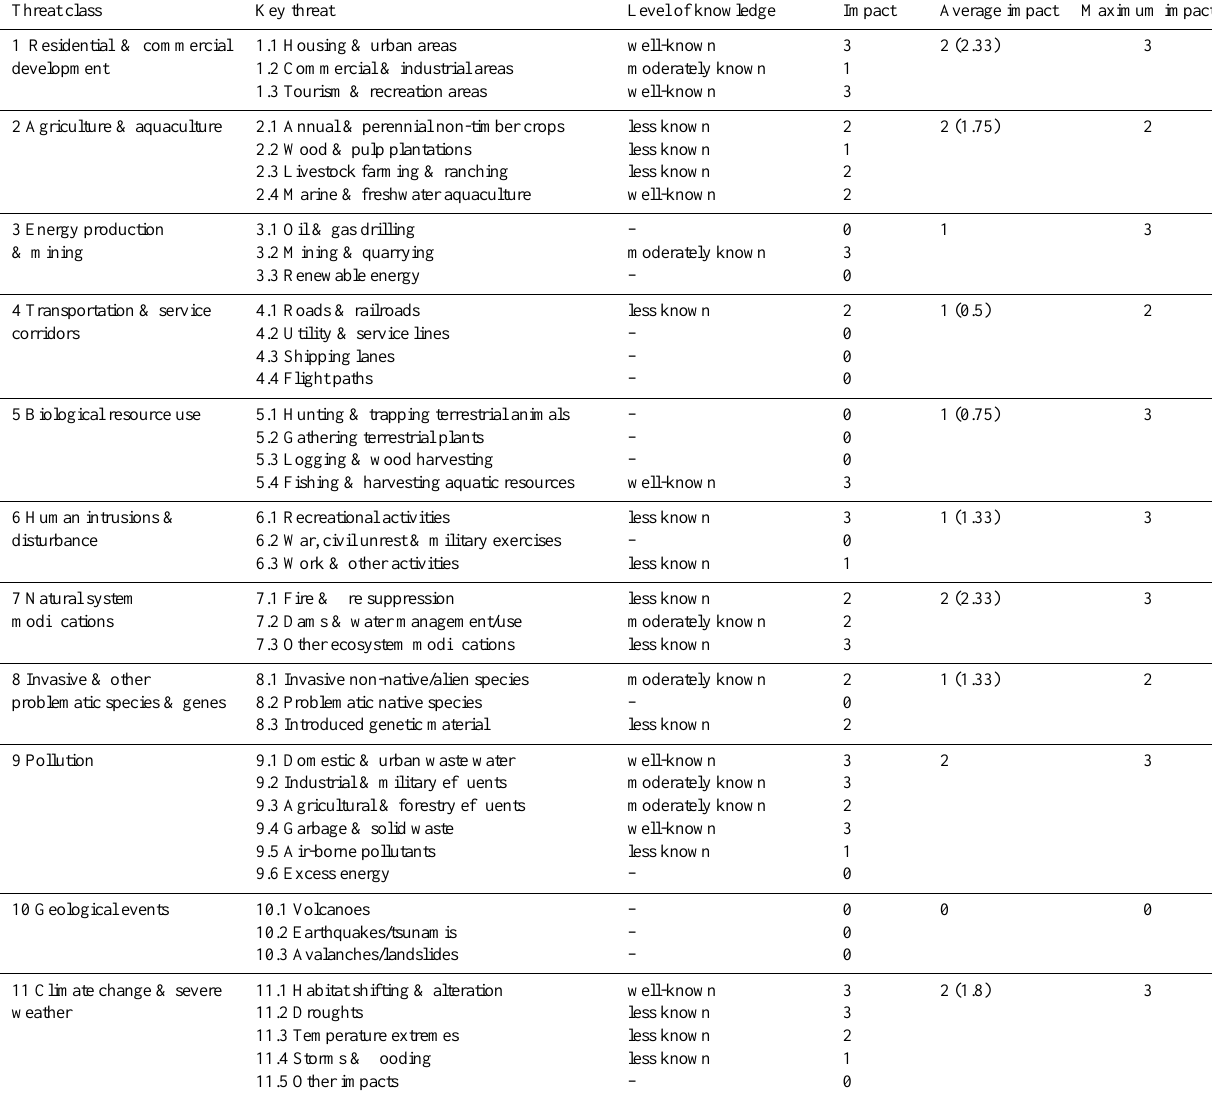
Table 1. Summary chart of IUCN threat classification scheme, key threats, current impact and expected future (mid-term) importance in the Ohrid basin. Four scores ranging from 0 (no know impact) through 1 (slight impact), 2 (moderate impact) to 3 (severe impact) were used to assess the current impact according to the scoring scheme provided by GIWA (2001). Average scores were calculated for each threat class and maximum values are also given. The level of knowledge regarding these threats is subjectively estimated. For details and references see